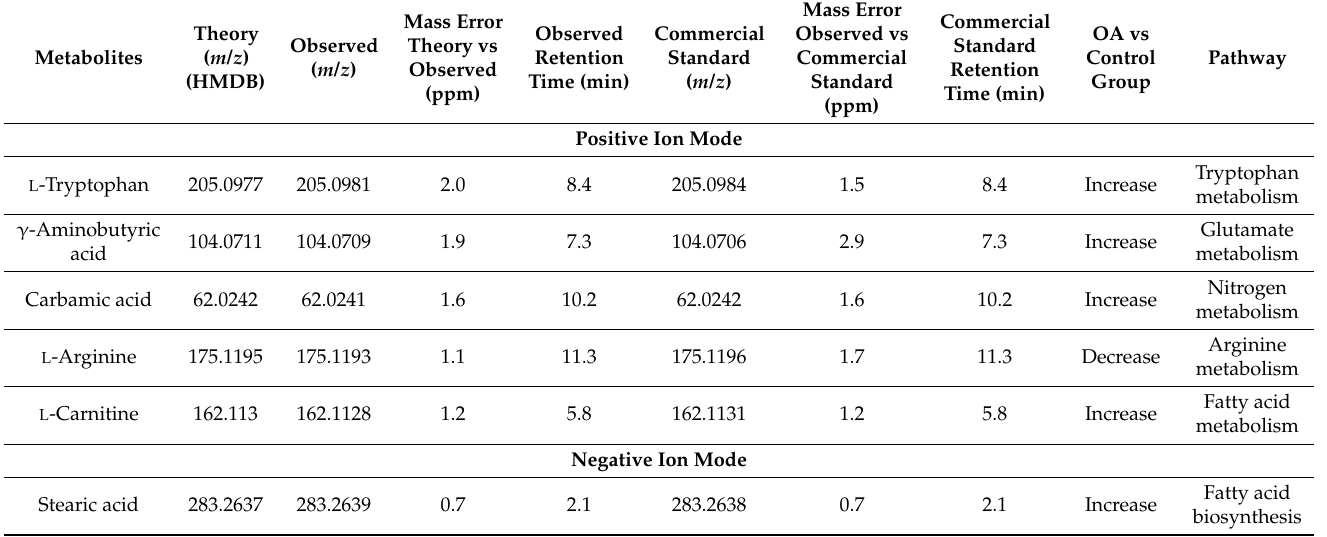
Table 2. Trends in identification results and